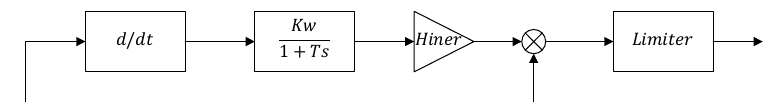
Figure 6. Schematic diagram of virtual inertia controller.